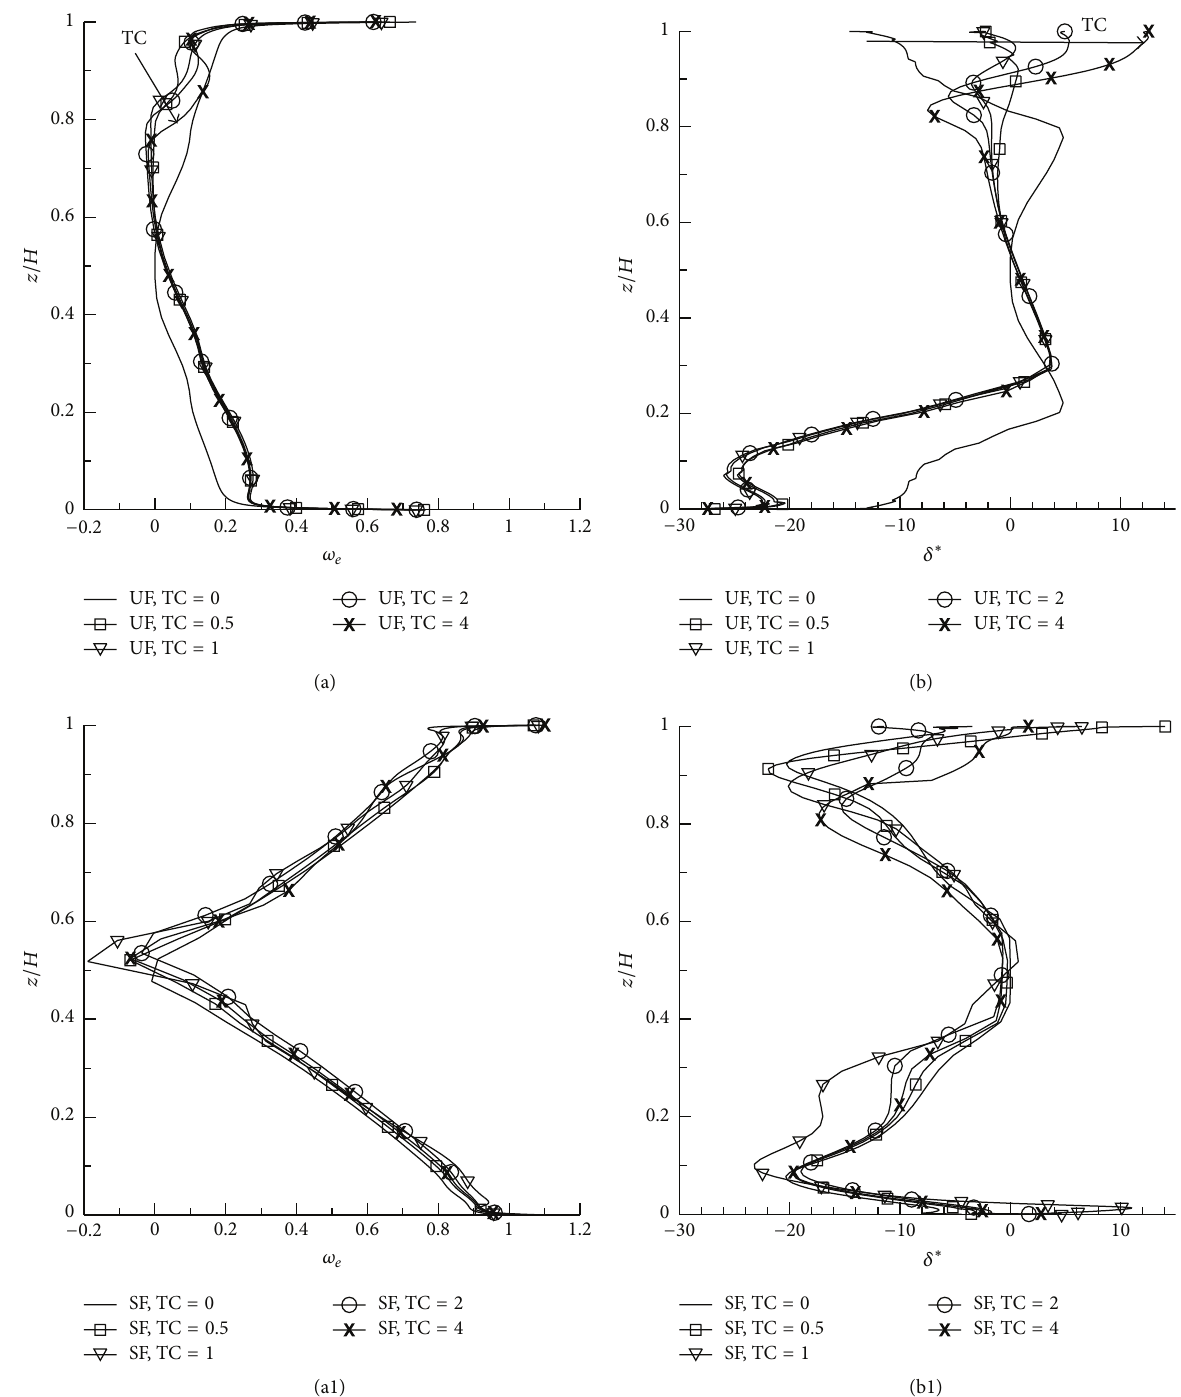
Figure 12: End wall loss and flow deviation with reference to exit flow angle along the span in the wake with UF and SF for TC = 0.5 to